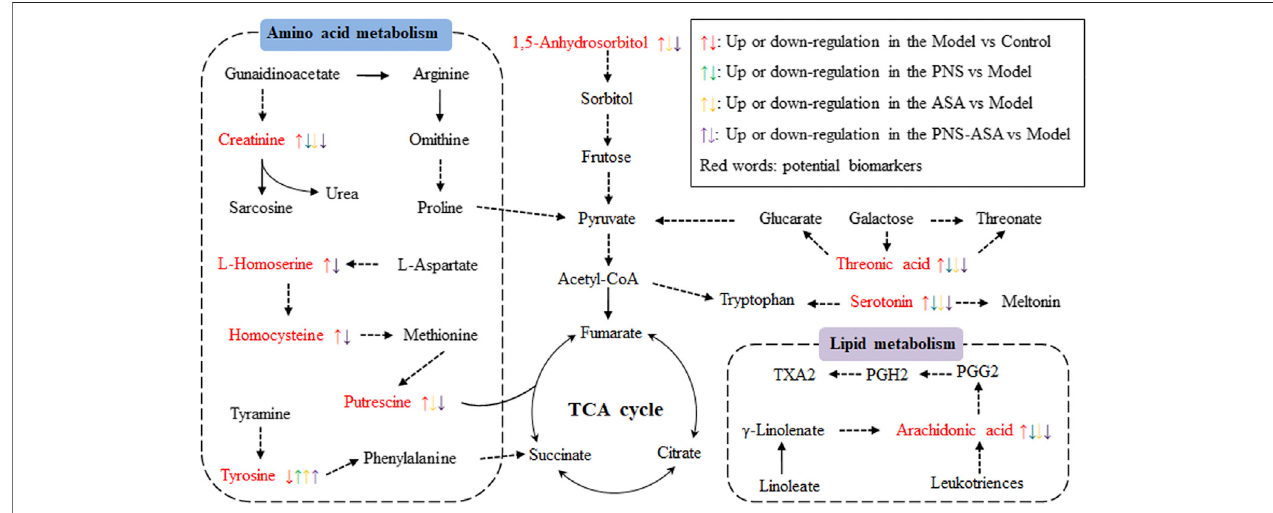
FIGURE 7 | Potential metabolic pathways affected by acute blood stasis and the in fl uence on the treatments of PNS, ASA, and the combined use of both drugs. Red words indicate potential biomarkers of acute blood